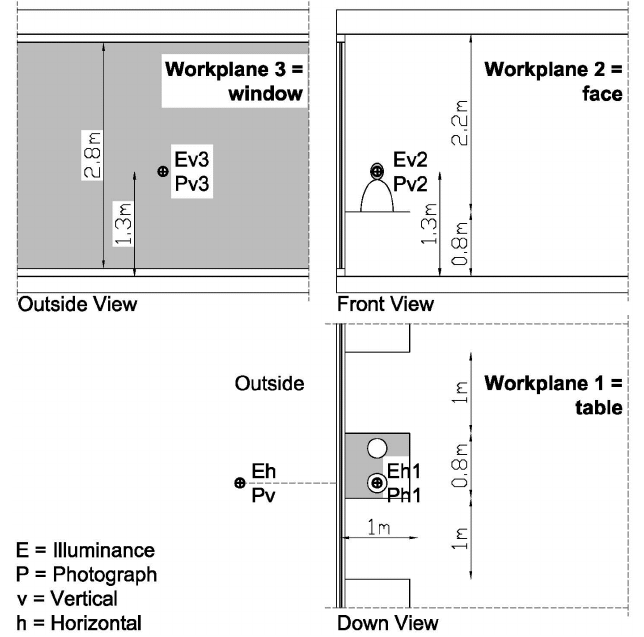
Figure 4. Workplane description. The three representative workplanes of dining activity next to the façade with illuminance measurement points and descriptions of pictures